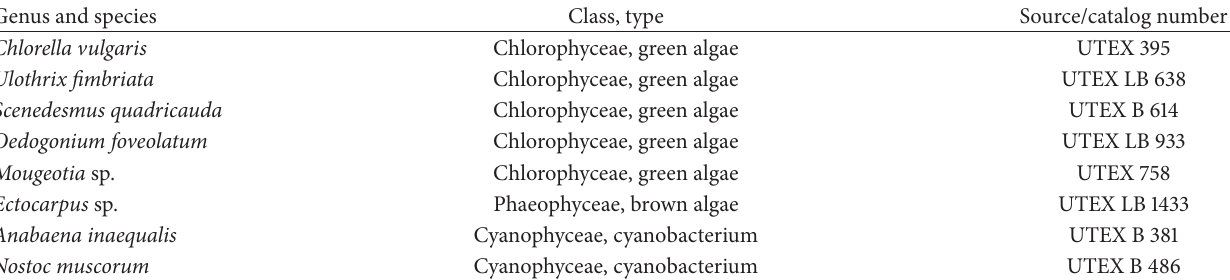
Table 1: Pure cultures for fingerprint database.